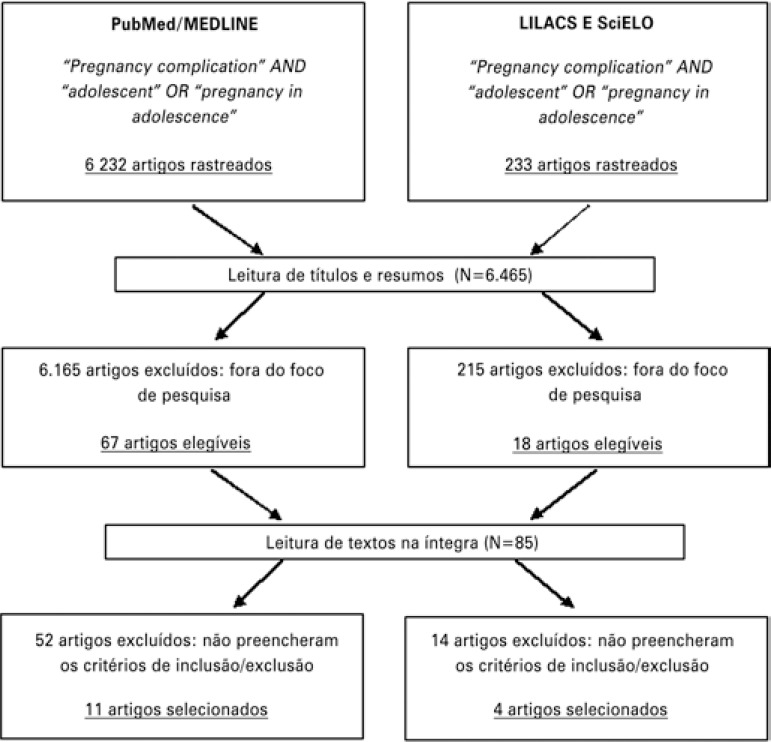
Fluxograma de identificação e seleção dos estudos da revisão sistemática